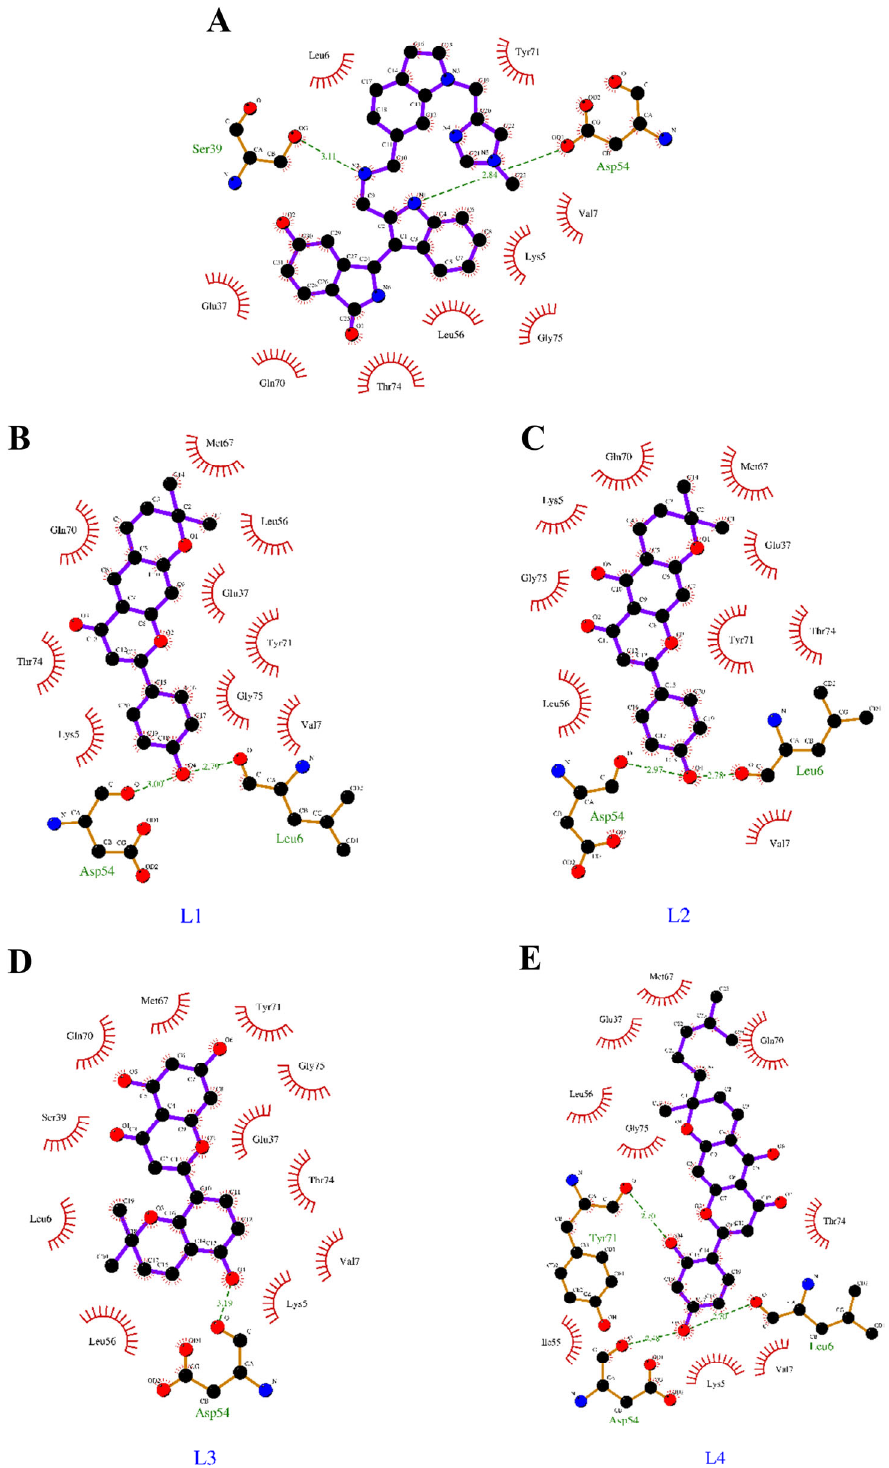
Figure 5. Ligplot interactions of 4 leads with KRAS G12D mutant protein: The protein–ligand interactions of BI-2852 (reference), 5-Dehydroxyparatocarpin K (L1), Carpachromene (L2), Sanggenone H (L3), and Kuwanol C (L4) are represented as ( A – E ), respectively. The H-bonds and other hydrophobic and electrostatic interactions of these compounds are also shown.